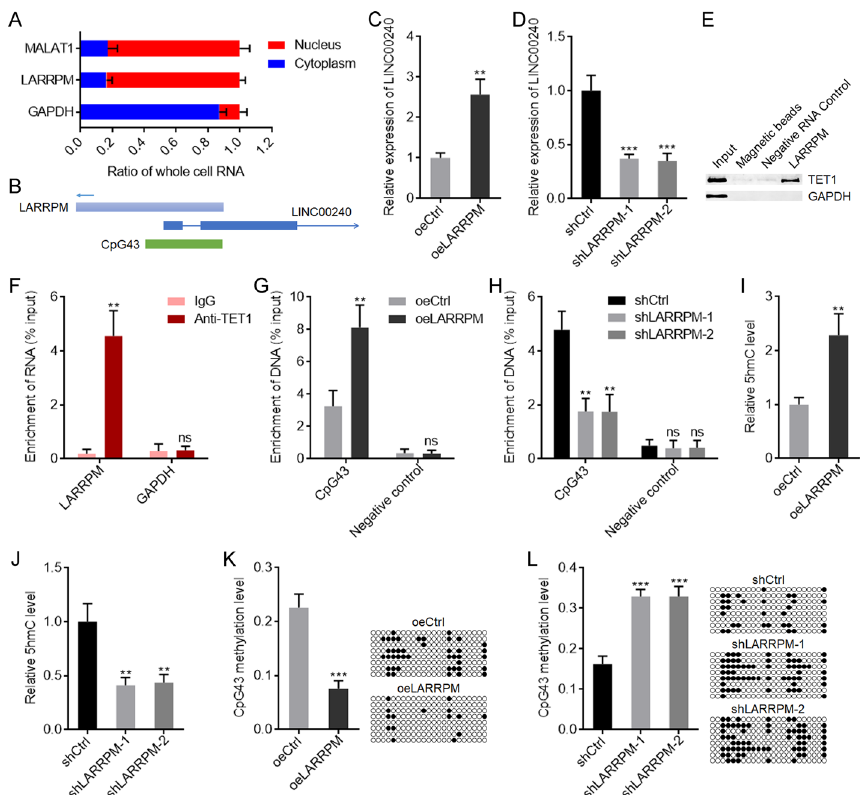
Fig. 4 LARRPM upregulated LINC00240 expression via inducing DNA demethylation. a Subcellular localization of LARRPM in A549 cells was detected using subcellular fractionation followed by qRT‑PCR. MALAT1 and GAPDH were used as nuclear and cytoplasmic controls, respectively. b The schematic diagram of the genomic localization of LARRPM and LINC00240 . c , d LINC00240 expression in A549 cells with LARRPM overexpression ( c ) and HCC827 cells with LARRPM depletion ( d ) was detected by qRT‑PCR. e RNA–protein pull‑down assays followed by western blot were performed to detect the proteins bound by LARRPM. f RNA immunoprecipitation (RIP) assays followed by qRT‑PCR were performed to detect the RNAs bound by TET1. g , h Chromatin immunoprecipitation (ChIP) assays followed by qPCR were performed in A549 cells with LARRPM overexpression ( g ) and HCC827 cells with LARRPM depletion ( h ) to detect the DNAs bound by TET1. i , j 5‑Hydroxymethylcyctosine (5hmC) levels of CpG43 from A549 cells with LARRPM overexpression ( i ) and HCC827 cells with LARRPM depletion ( j ) were measured using the EpiMark 5‑hmC Analysis Kit. k, l DNA methylation levels of CpG43 from A549 cells with LARRPM overexpression ( k ) and HCC827 cells with LARRPM depletion ( l ) were measured using bisulfate DNA sequencing. Results are shown as the mean three independent experiments. Asterisks indicate a significant difference at ** P < 0.01, *** P < 0.001; ns, not significant, by Student’s t ‑test ( c , f , g , i , k ) or one‑way ANOVA followed by Dunnett’s multiple comparisons test ( d , h , j , l ). GAPDH Glyceraldehyde 3‑phosphate dehydrogenase, LINC00240 a long LUAD‑related non‑coding RNA, MALATI a long non‑coding RNA, TET1 a DNA